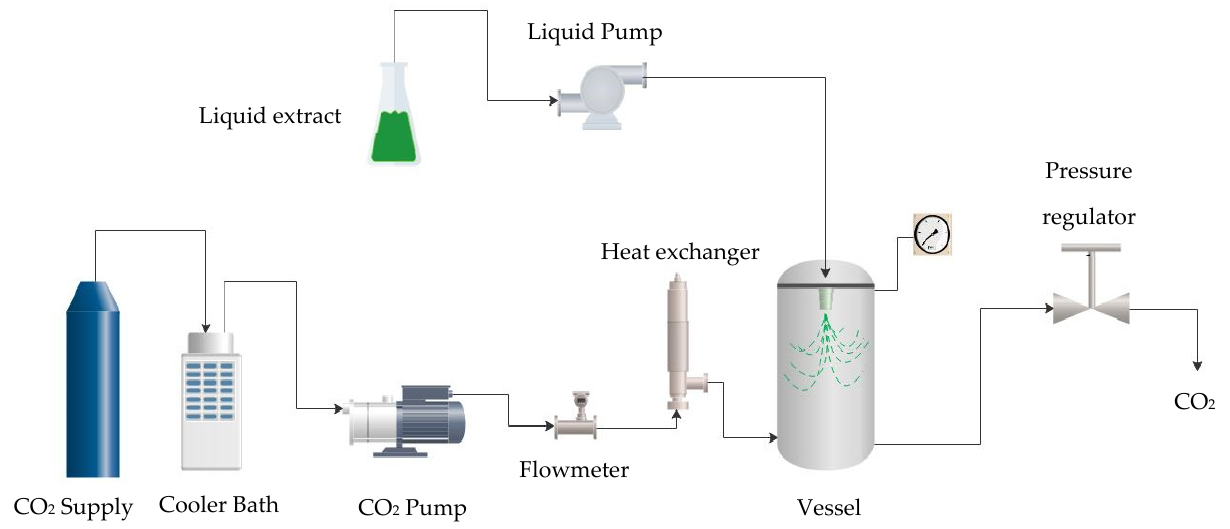
Figure 1. Schematic diagram of precipitation equipment.